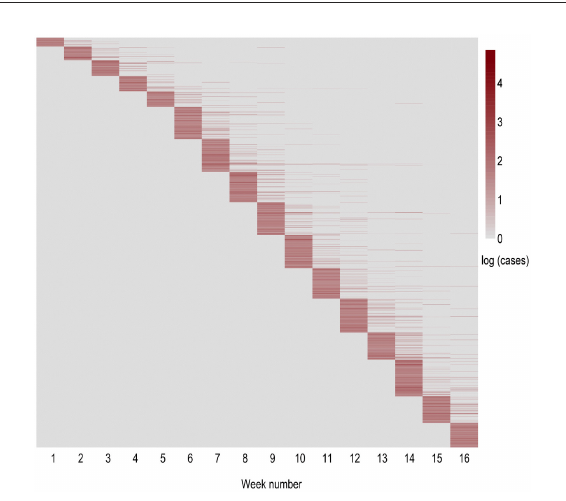
FIGURE2 Heatmap of the weekly evolution of new positive cases within each outbreak in natural logarithmic scale. The horizontal axis indicates the evolution within the period of study in weeks. The vertical axis represents the order of appearance of each outbreak. Thus, each row displays an outbreak, while each column corresponds to the new cases reported in that outbreak in each of the following weeks (period of 16 weeks from September 15th till December